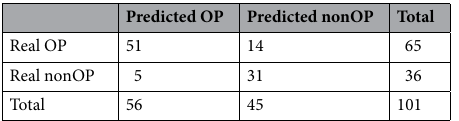
Table 1. Confusion matrix of the final model. OP